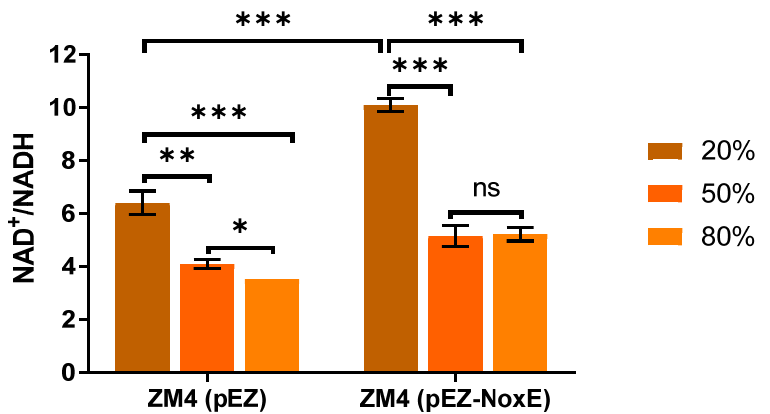
Figure 4. The NAD + /NADH ratios in the recombinant strains of ZM4 (pEZ) and ZM4 (pEZ-NoxE) strains. Strains were cultured in 100-mL shake flakes containing 20 mL (20%), 50 mL (50%) and 80 mL (80%) medium at 30 °C, 100 rpm. Values are the means of experiments with three or more technical replicates, and error bars are standard deviations. A p -value less than 0.05 is considered to be statistically significant (* p < 0.05; ** p < 0.01; *** p < 0.001). ns: not significant.